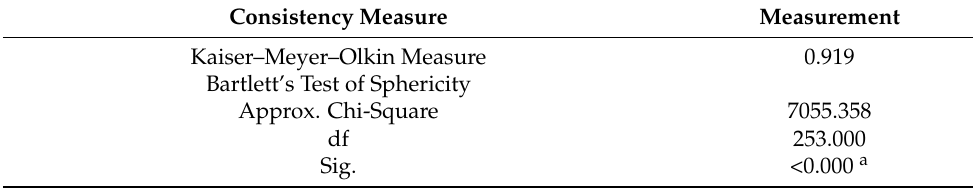
Table 3. Internal consistency measures.